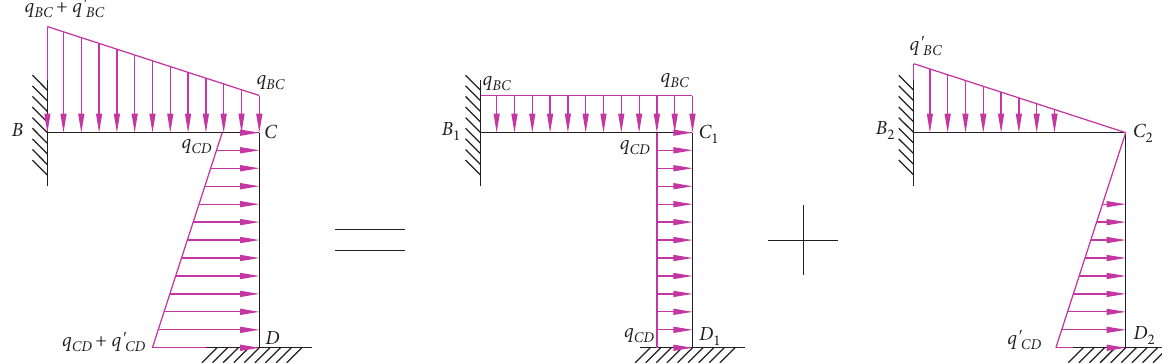
Figure 8: The load decomposition of BCD : (a) trapezoidal load; (b) rectangular load; (c) triangular